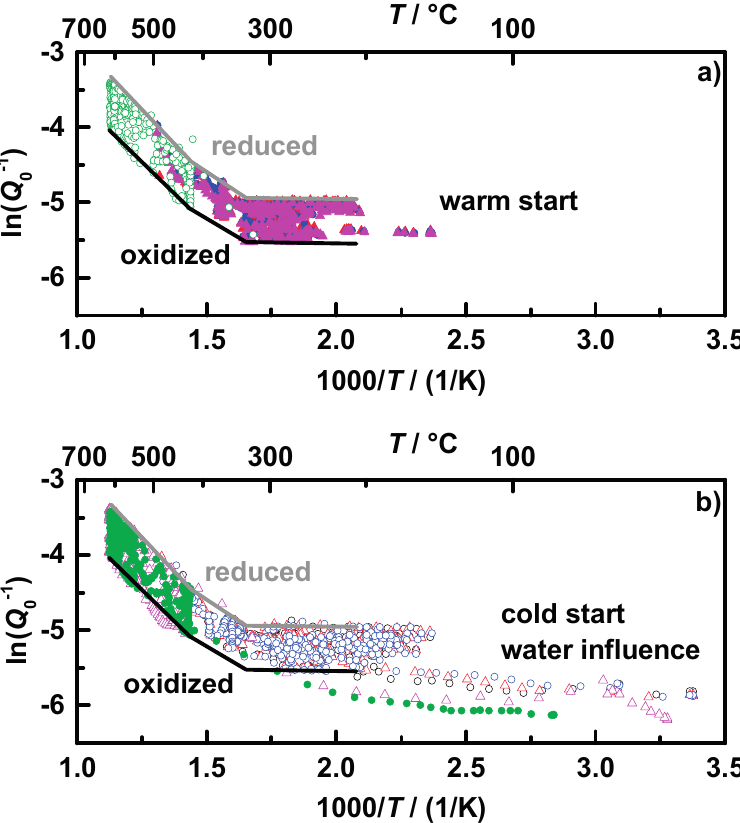
Figure 4. Arrhenius-like representation of Q 0 − 1 of the conducted NEDC and OSC runs with sample C1 according to Figure 3b: ( a ) warm start and ( b ) cold start conditions, with the characteristic curve of the oxidized (black) and reduced (grey) state; each differently colored data set represents one experimental run. The same labels as shown in Figure 3